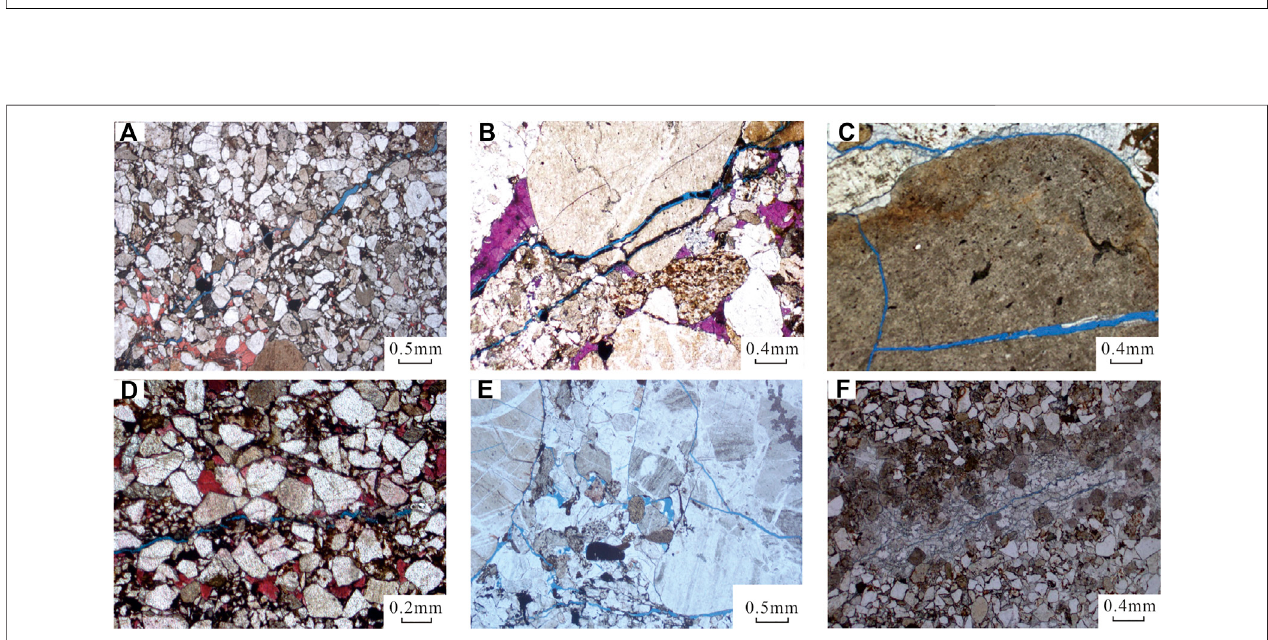
FIGURE4|(A) WellZ102-1,6,906.12 m, microfractureextendingalonggrainedgewithan opening ofabout 0.1mm; (B) WellZ101-2,7,078.83 m, microfracture extending through the particles, with argillaceous semi- fi lled in the fracture, and has an opening of about 0.1 mm; (C) Well Z103, 7,399.16 m, microfracture fi lled with anhydrite in the gravel, and microfractures seen at the edge of the gravel; (D) Well Z104, 6,799.9 m, microfractures distributed along the grain edge; (E) Well Z104-2, 7,005.50 m, microfracture found in the gravel and at the edge of the gravel; (F) Well Z7, 7,550.6 m, several microfractures developed in local dolomite strips.